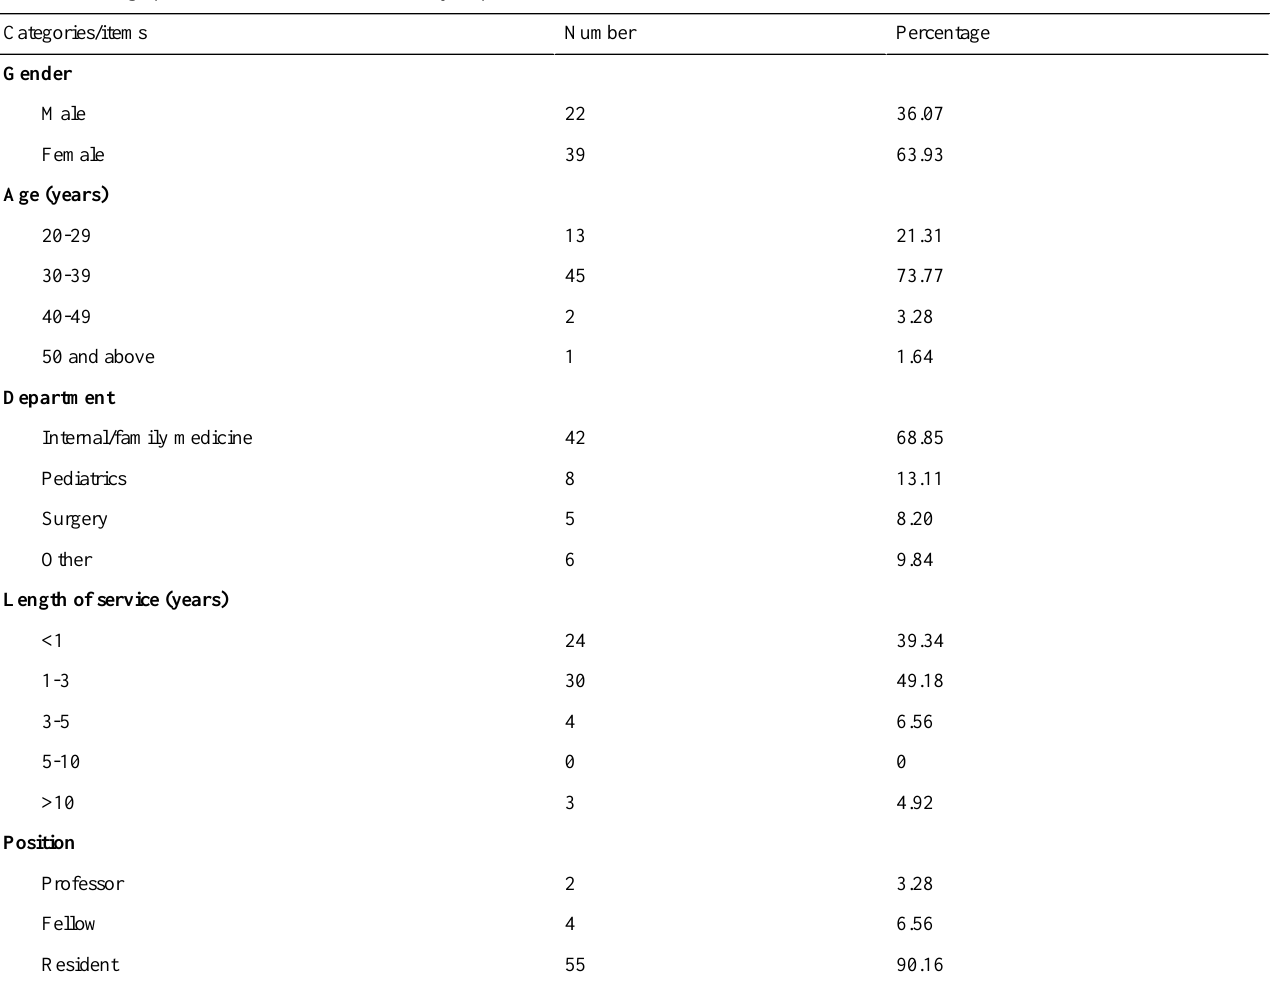
Table 2. Demographic characteristics of SEM survey